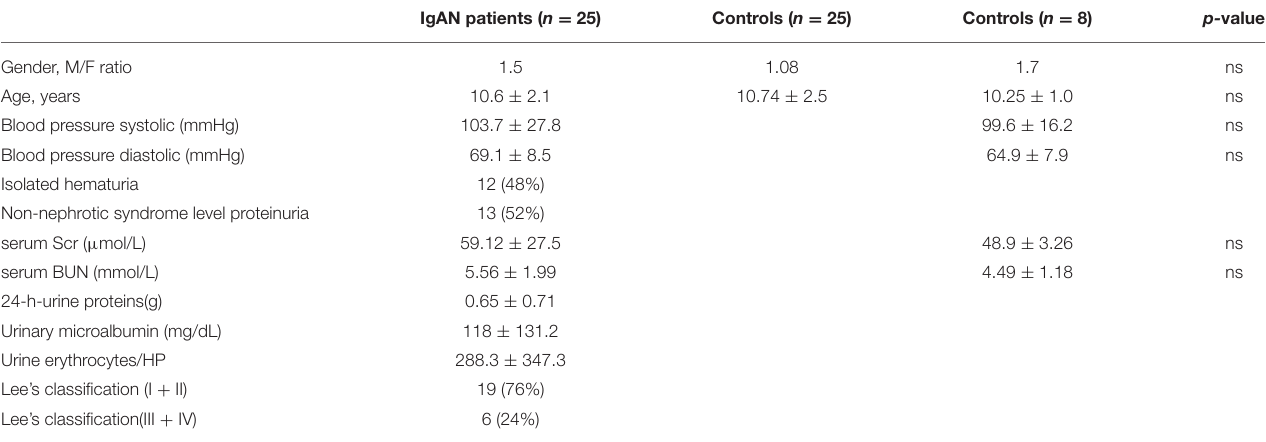
TABLE 1 | The demographic and clinical characteristics of